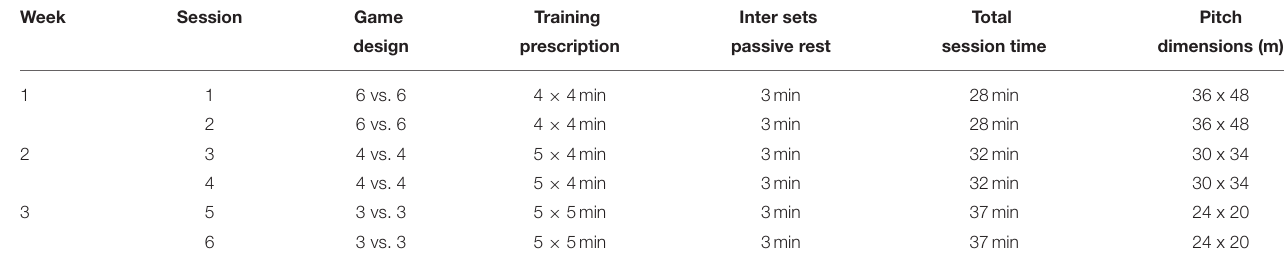
TABLE 2 | Small-sided game-specific soccer training program distribution over the 3-week training. Week Session Game Training Inter sets